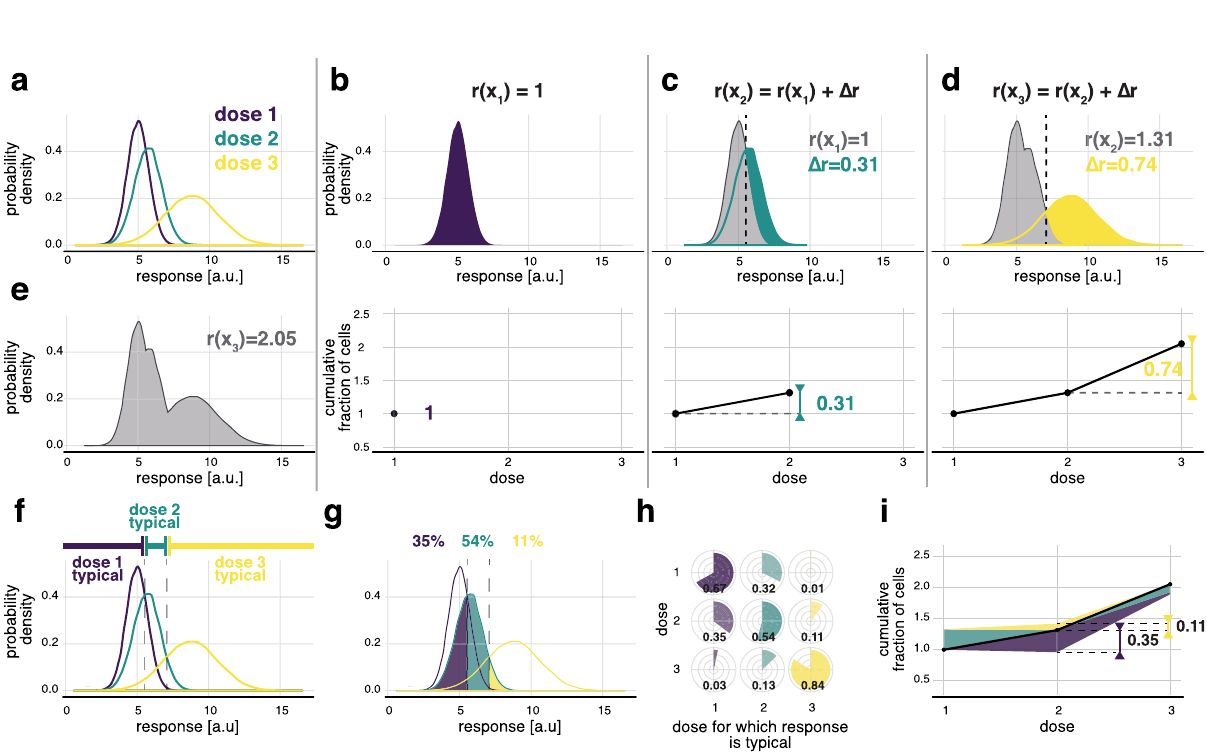
Fig. 1 Dose – responses to IFN- α 2a in PBMCs. a t-SNE plots constructed based on phenotypic markers. Cell types are encoded by color and each dot represents a single cell. b t-SNE plots of whole-cell pSTATs levels 15 min after stimulation with two selected doses of IFN- α 2a as well as in unstimulated cells. Positions of dots corresponding to single cells are the same as in a allowing cell type identi fi cation. The color of each dot represents normalized (0 for minimum and 1 for maximum) mass cytometry signal. Analogous t-SNE plots for all considered doses are shown in Supplementary Fig. 3. c Mean pSTATs levels in fi ve cell types as a function of the dose calculated from mass cytometry signals of single cells. The mean of log-data and medians are shown in Supplementary Fig. 4a, b. d Distributions of responses in fi ve cell types after stimulation with different doses of IFN- α 2a in terms of pSTAT1 (top row) and pSTAT5 (bottom row) as measured with mass cytometry. The shown probability density is proportional to the frequency of cells with a given level of the pSTAT. The value of the probability density is proportional to the frequency of cells with given response levels. Distributions of other pSTATs are shown in Supplementary Fig. 4c. Different doses correspond to different colors. Technical details: at least 2500 cells were measured per condition. The plot shows one representative of two biological replicates.